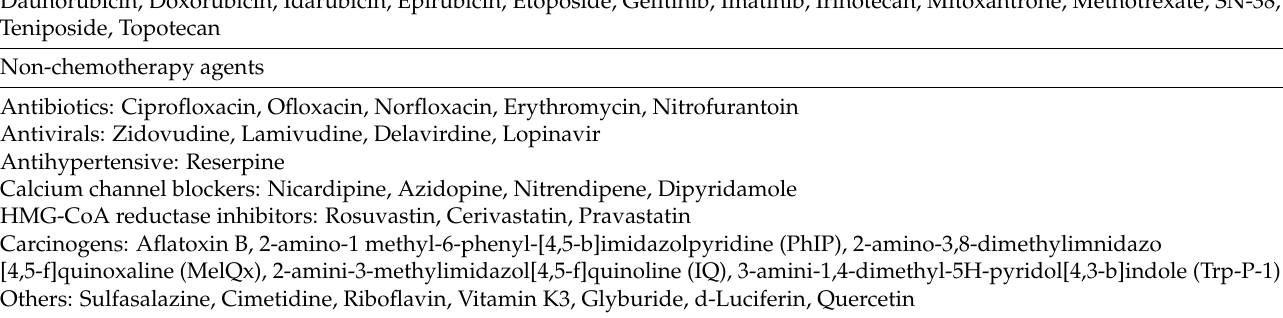
Table 1. Selected substrates of ABCG2 1